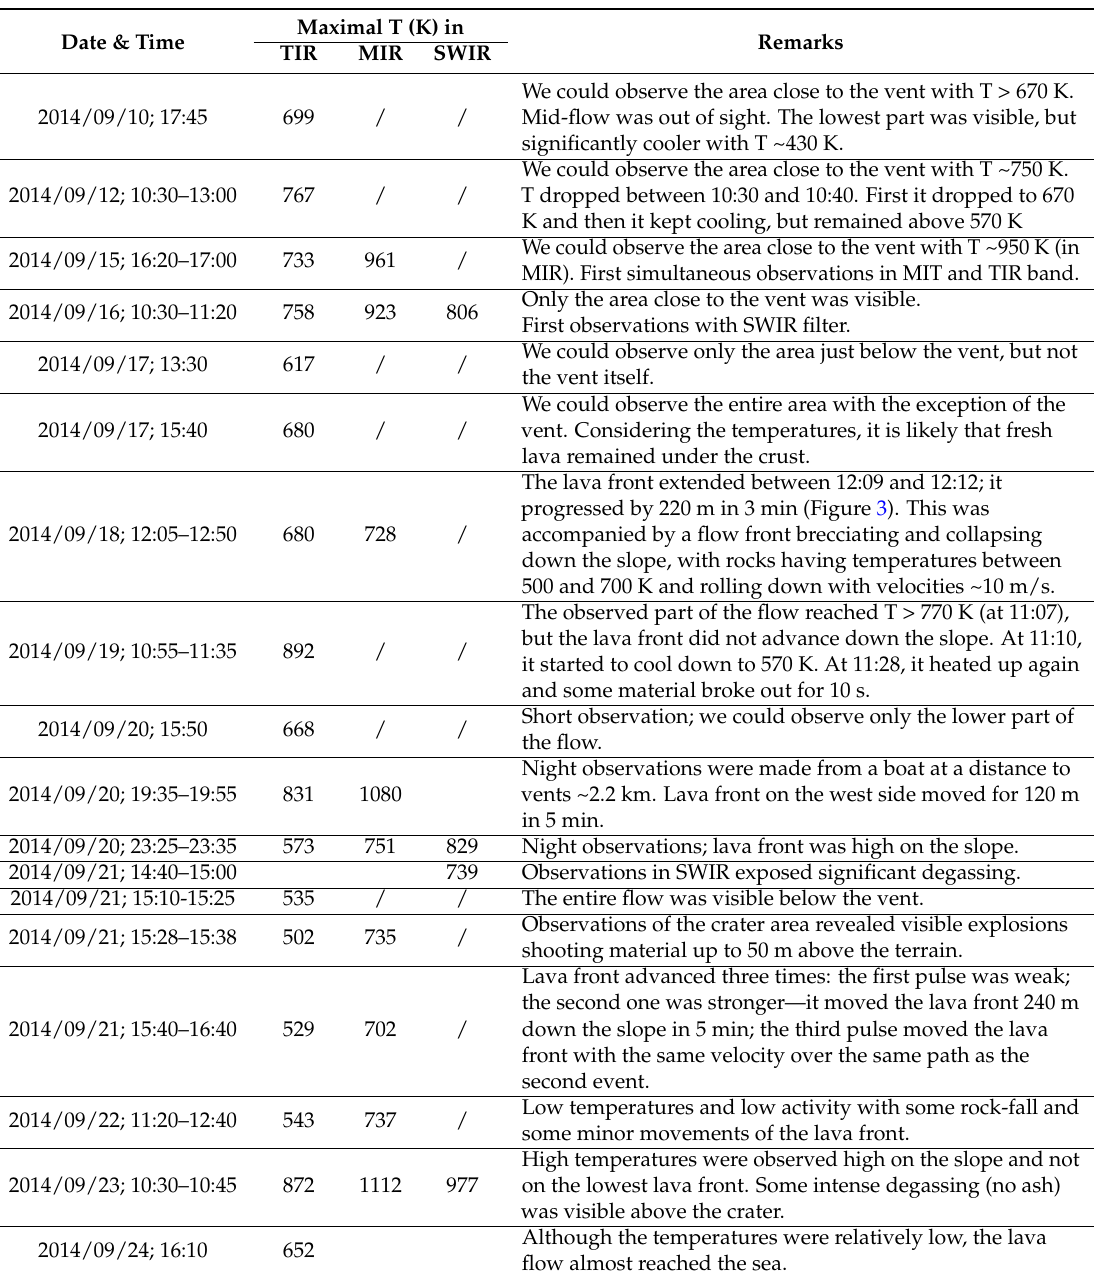
Table 4. Log of field observations; please note that we also used a 2.4 µ m filter on the Image IR camera, however the atmosphere interfered significantly with this band as it lies on the edge of the atmospheric window. Thus the filter was not used in the quantitative